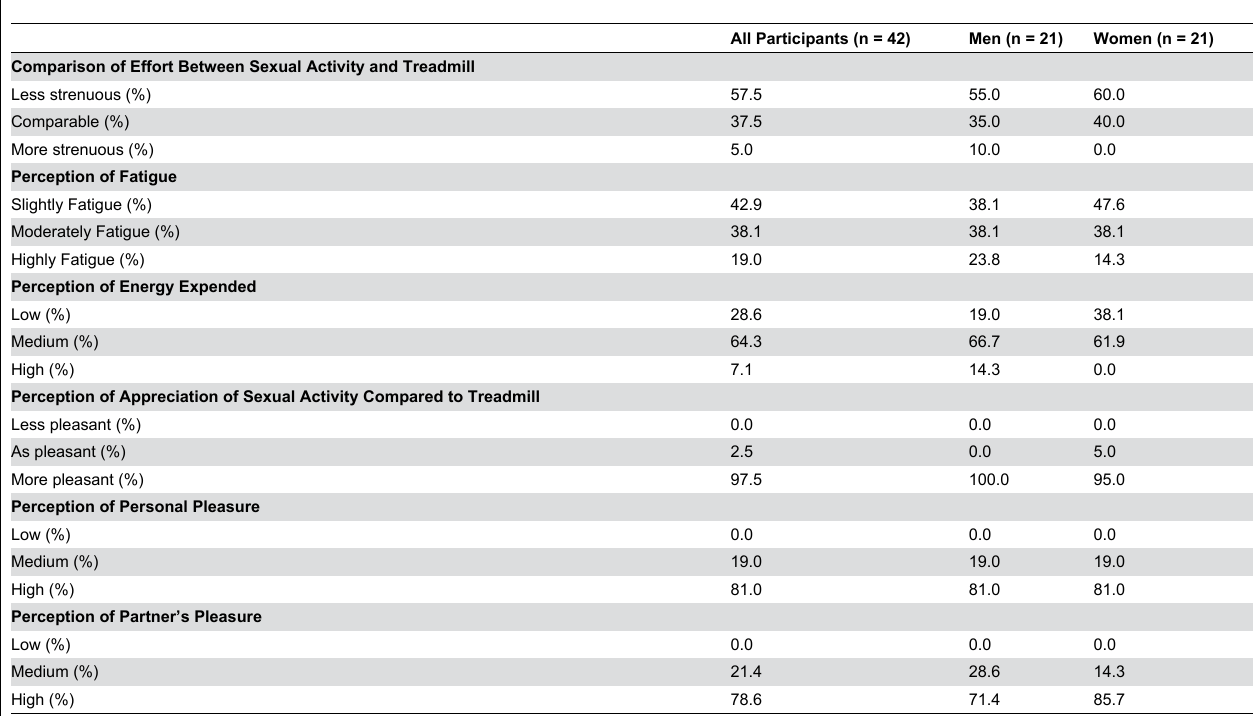
Table 2. Perception of effort, fatigue, appreciation and pleasure after the sexual activity in men and women.